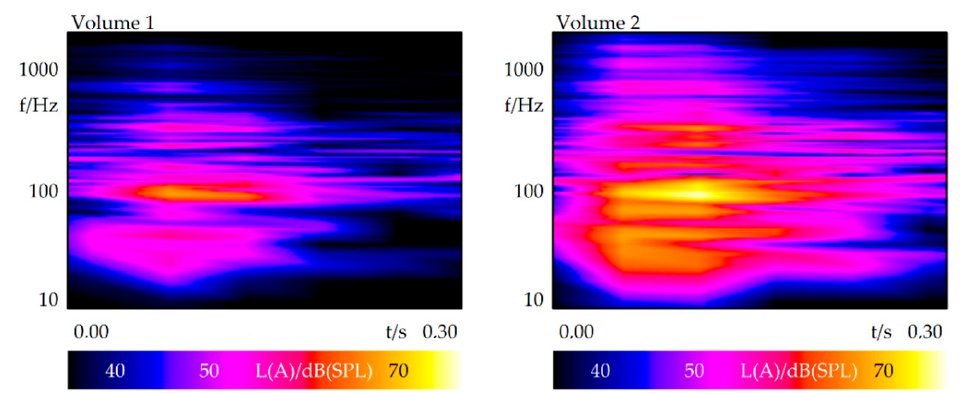
Figure 3. Representative sound pressure level at the driver’s ear, volume 1 ( Left ) and volume 2 ( Right ), when driving over 30 mm falling edge with the rear wheels; visualized with Artemis Suite (HEAD